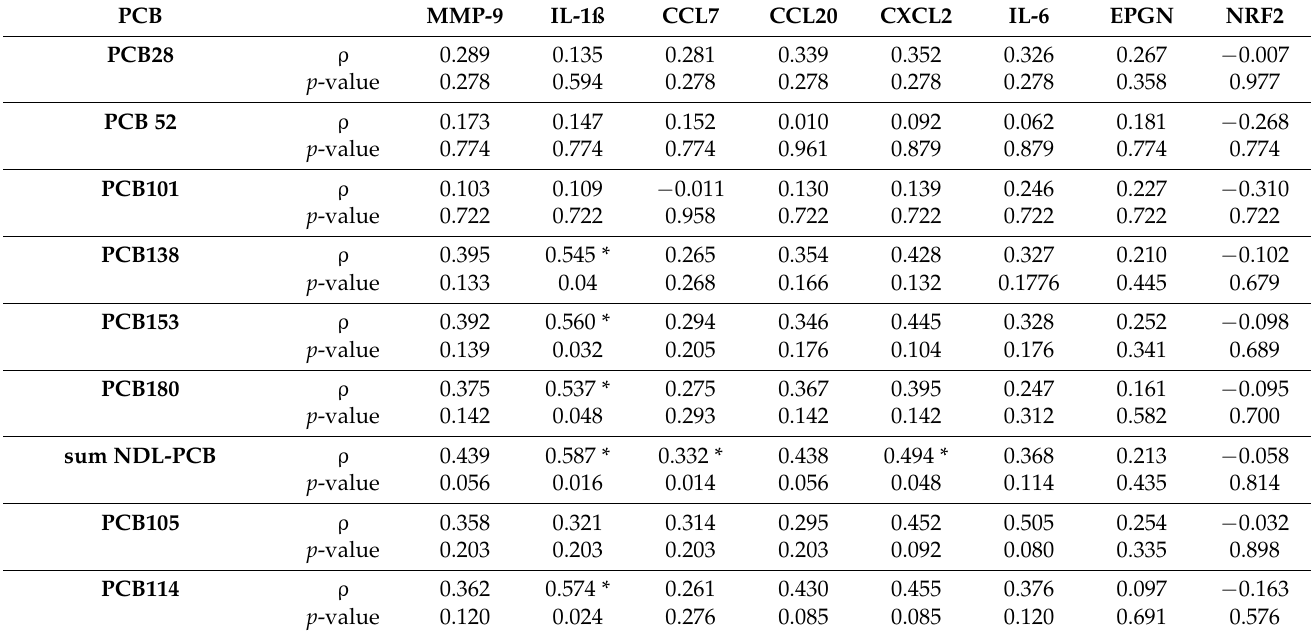
Table 3. Correlation between dioxin (PCDD/Fs) and plasma PCB levels and cutaneous gene expression.